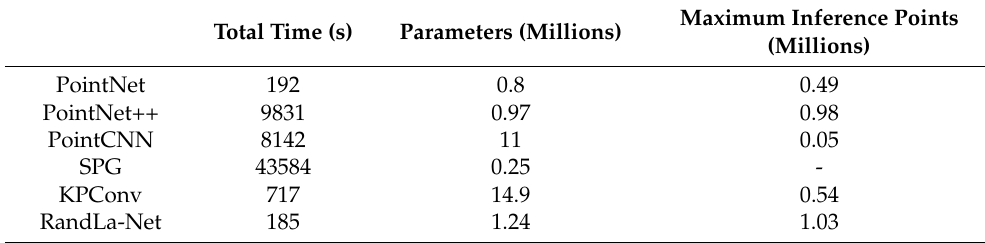
Table 3. Efficiency of the semantic segmentation of different methods on sequence 08. Maximum Inference Points Total Time (s) Parameters (Millions) (Millions) PointNet 192 0.8